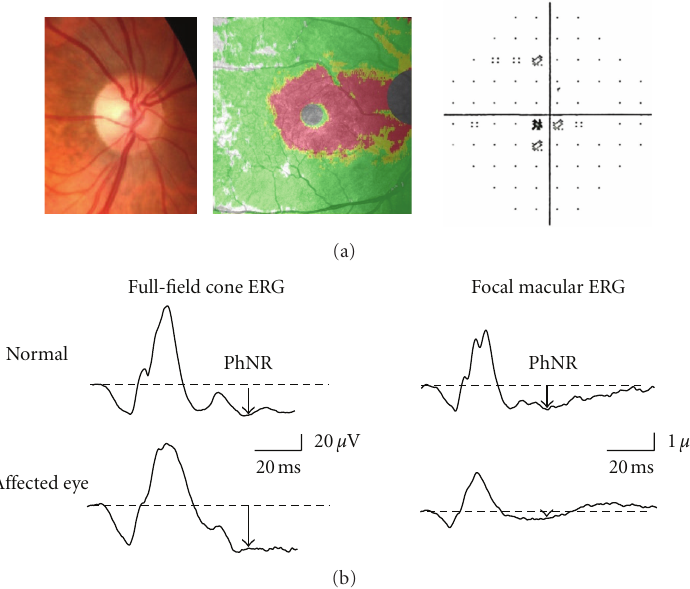
Figure 5: A representative case of optic nerve atrophy. (a) Optical coherence tomography detected abnormally thinning area of ganglion cell complex thickness (indicated by red area). Standard automated perimetry demonstrated central scotoma. (b) The full-field cone and focal macular electroretinograms (ERGs) recorded from a normal subject and the representative case. PhNR: photopic negative